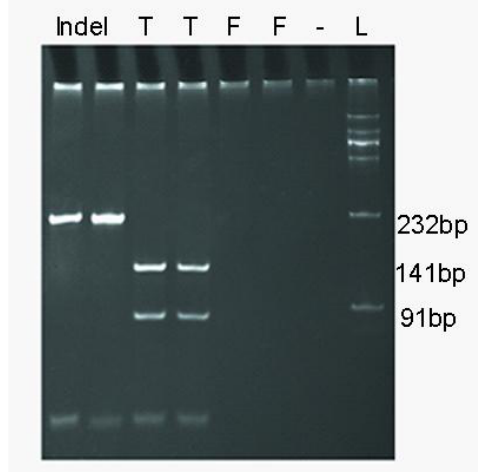
Figure 1. Polymerase chain reaction (PCR) products of Y-45288 locus analyzed by PCR-restriction fragment length polymorphism (RFLP). Individuals with T nucleotide yielded fragments of 91 and 141 bp, while individuals with T deletion only have 232 fragments (Indel, individuals with T deletion; T, individuals with T nucleotide; F, female; -, blank; L,